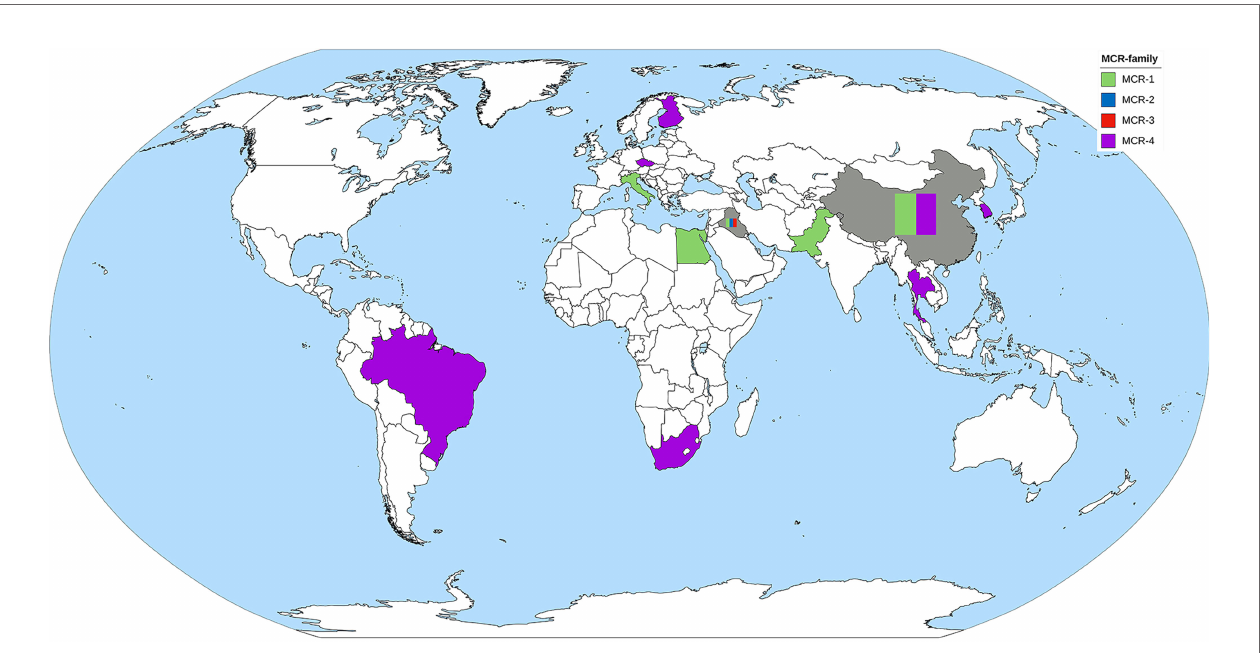
FIGURE 4 | The worldwide dissemination of the mcr gene in Acinetobacter spp. Countries that reported only one type of mcr gene were colored to represent the mcr gene. Countries that reported more than one type of mcr gene were fi lled with gray background containing color bands of the reported mcr gene.